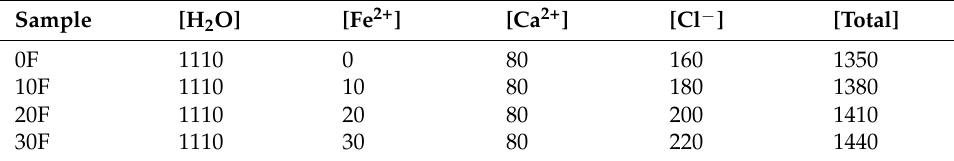
Table 1. Composition of the CaCl 2 solution studied by Gromacs.